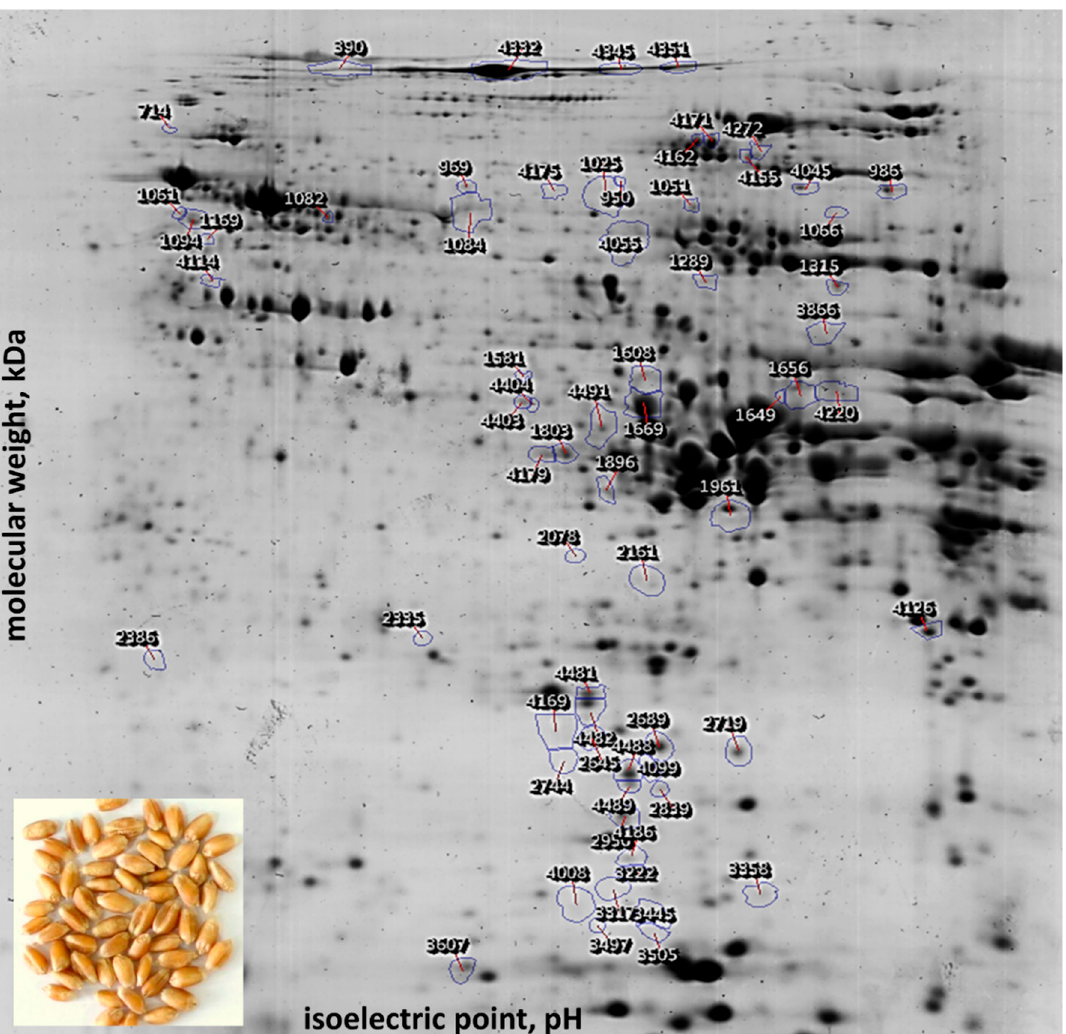
Figure 1. Annotated gel with 66 differentially abundant protein spots among modern and traditional cultivars marked on the image of alignment reference using the SameSpots 5.1 program. In total, 810 analytes extracted from the grain of bread wheat were separated in the 4.0–9.5 pI range and 11–129 kDa molecular mass interval.